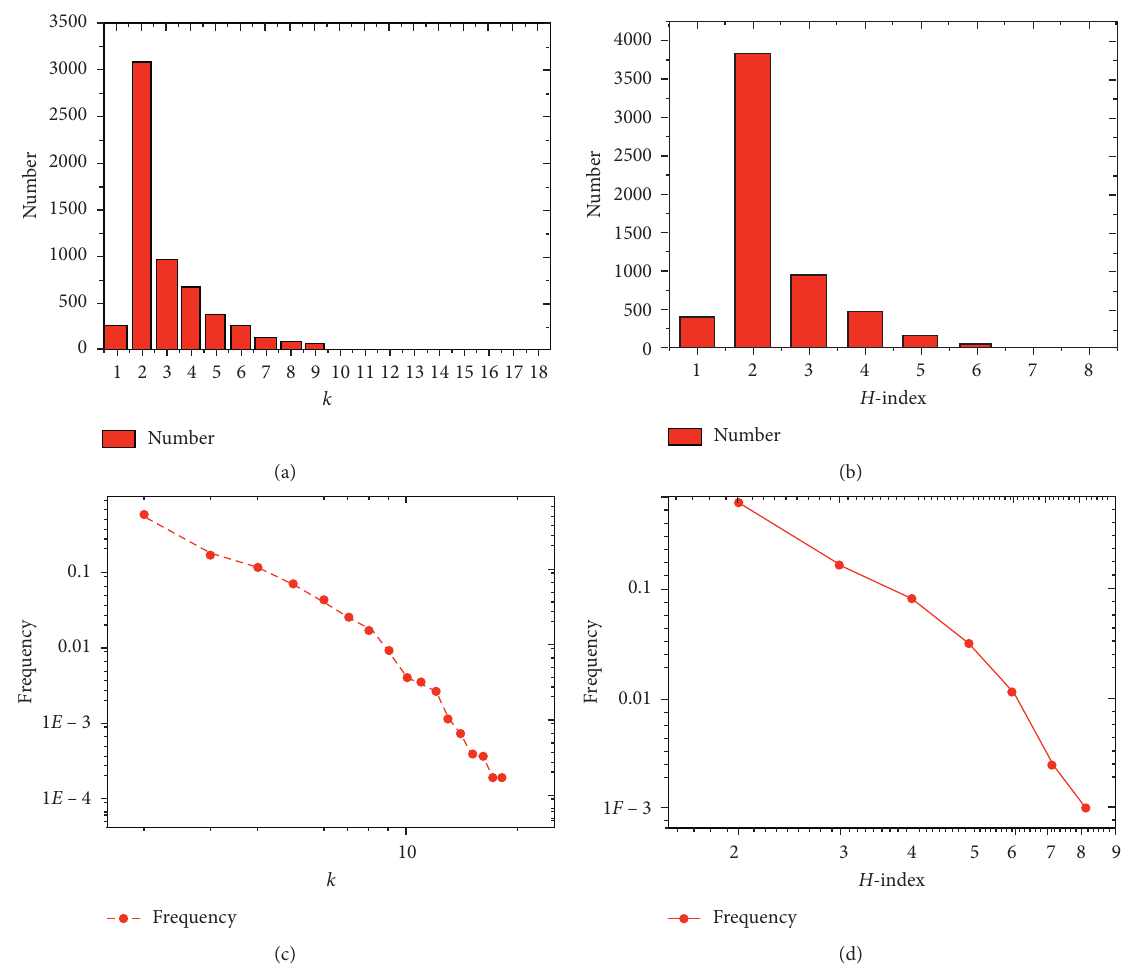
Figure 10: The properties of the bus network. (a) The number of stations’ degrees. (b) The number of stations’ H -index. (c) The frequency distribution of stations’ degree. (d) The frequency distribution of stations’ H